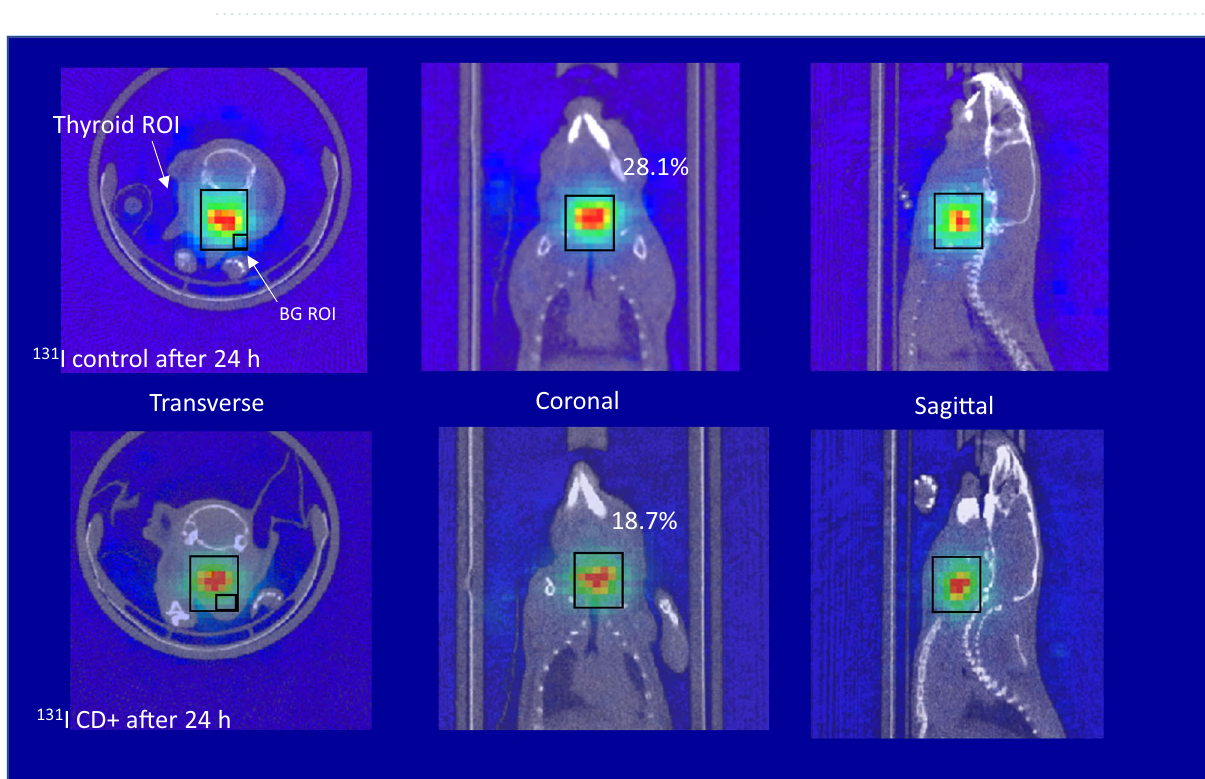
Figure 3. The 24-h thyroid single-photon emission computed tomography (SPECT) images of Na 131 I + α-CD- administered mice and control mice with normal thyroid function (in which the α-CD solution was replaced with